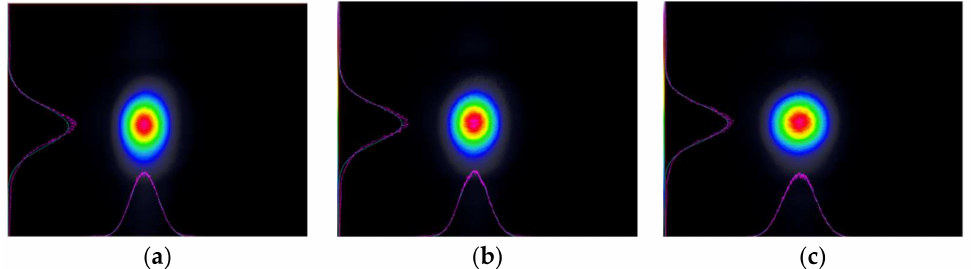
Figure 6. The amplified beam profile of the fundamental laser with a pump power of 7 W at different pump powers of the seed. ( a ) Beam profile with circularity of 0.661, as the pump power of the seed was 2.4 W; ( b ) beam profile with circularity of 0.747, as the pump power of the seed was 3.3 W; ( c ) beam profile with circularity of 0.927, as the pump power of the seed was 3.9